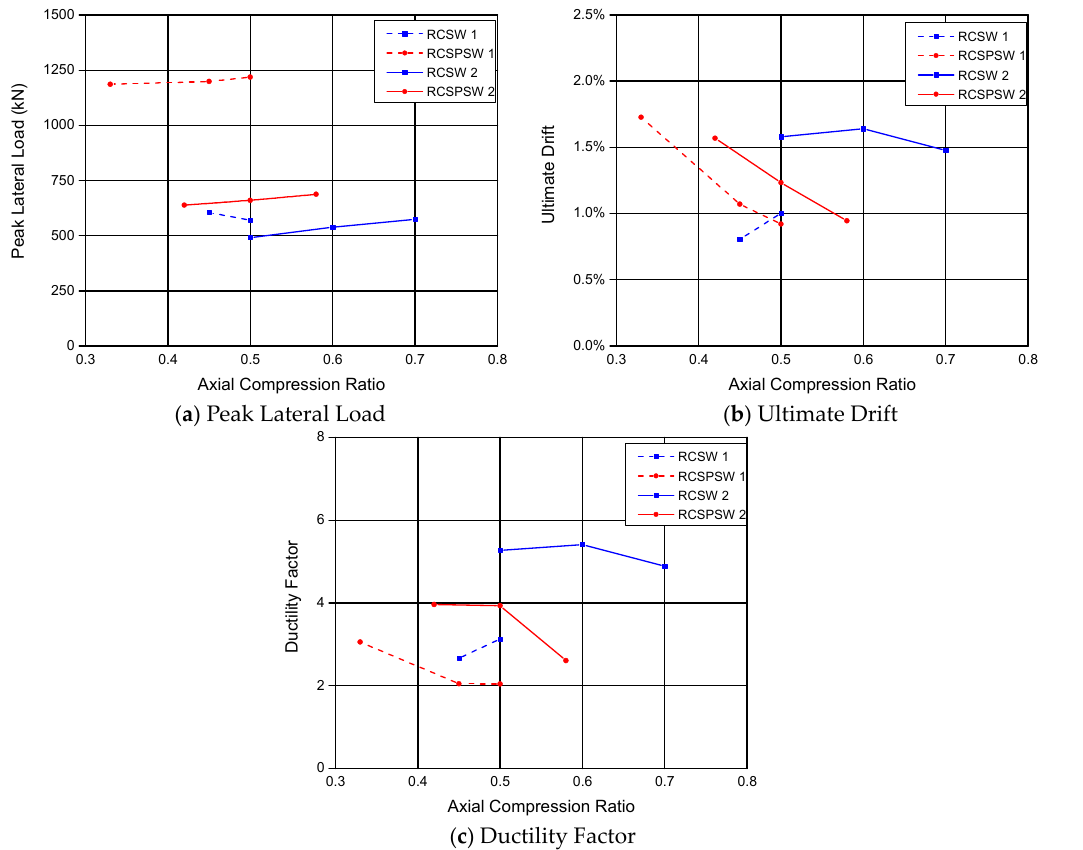
Figure 15. Effects of Axial Compression Ratio on ( a ) Peak Lateral Load; ( b ) Ultimate Drift; and, ( c ) Ductility Factor.